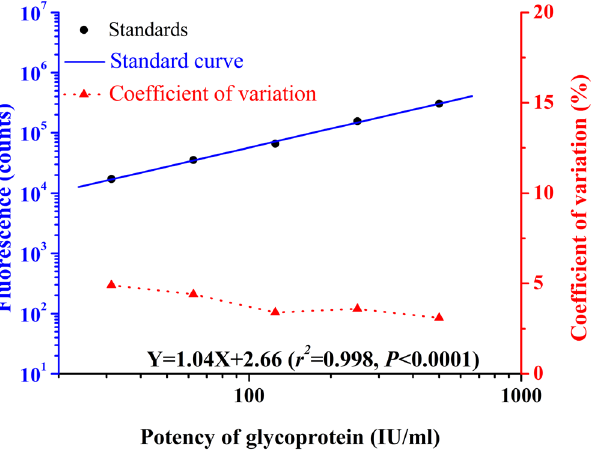
Figure 2. Standard curves and intra-assay precision profile for the present TRFIA (each point was based on 10 replicates).